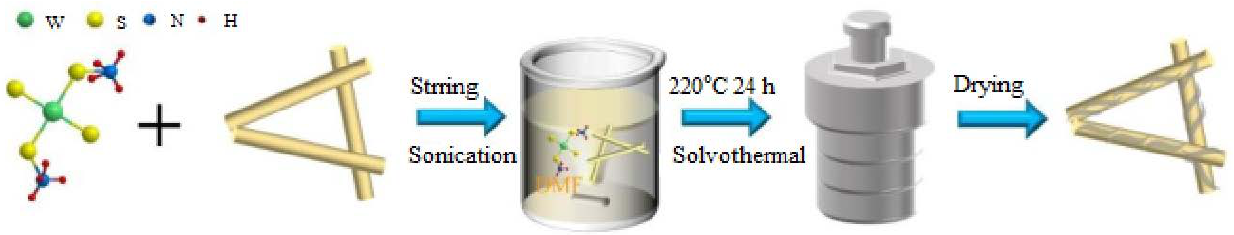
Figure 7. Schematic illustration for the synthesis process of WS 2 /Sep